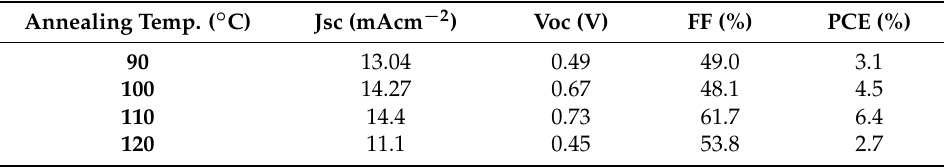
Table 3. Photovoltaic performance parameters of glass/FTO/TiO 2 /CH 3 NH 3 PbI 3-X /CuSCN/Au device annealed at different temperatures.